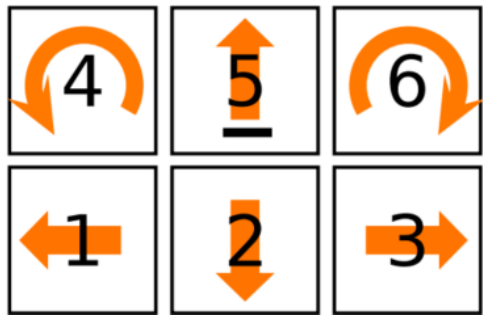
Figure 15. Mapping of the keys of the numeric keypad to direct the avatar. This key mapping was selected as num-5 key usually has an ergot making it easier to